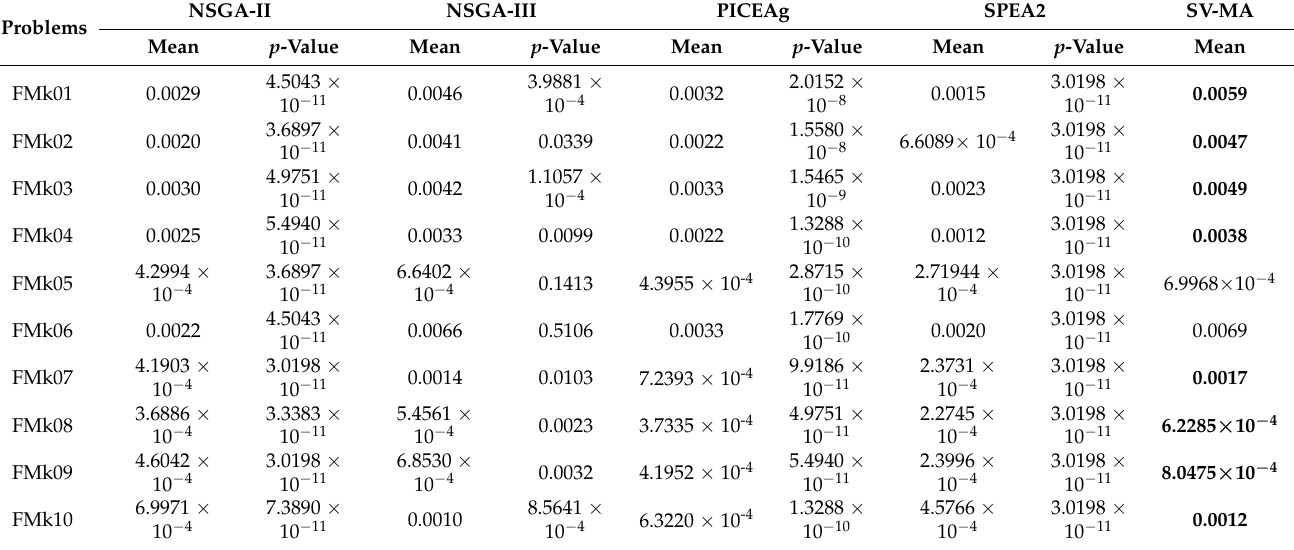
Table 5. Statistical values of